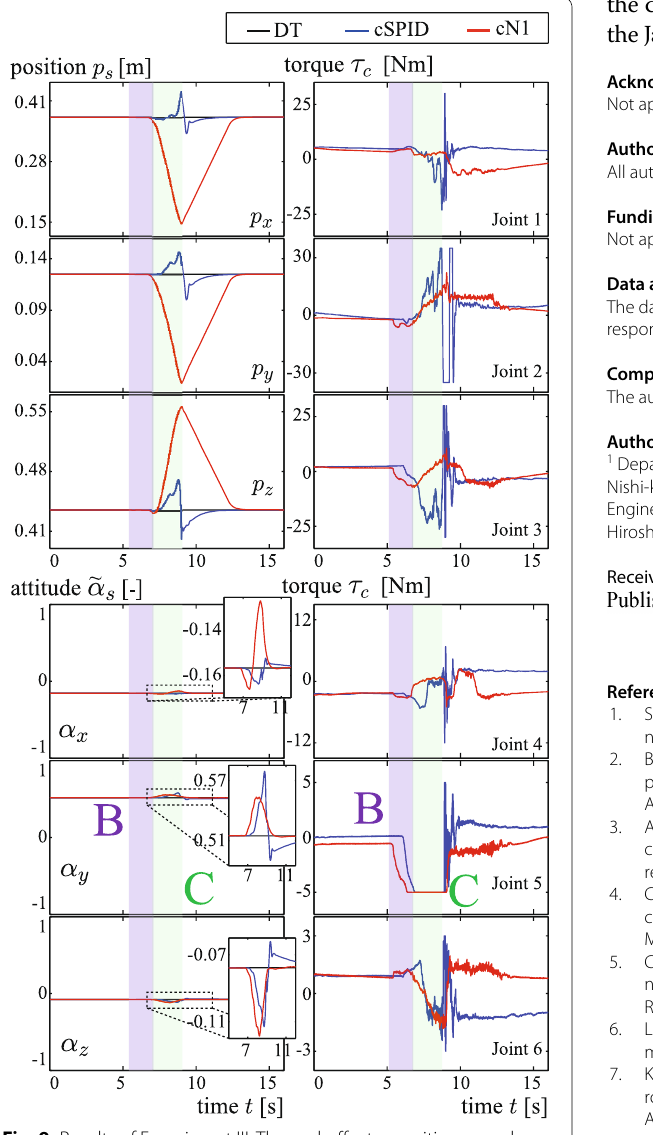
Fig. 9 Results of Experiment III. The end-effector position p s and attitude ˜ α s and each joint torque during a set-point controller under cN1 where a desired trajectory is pointed in Fig.